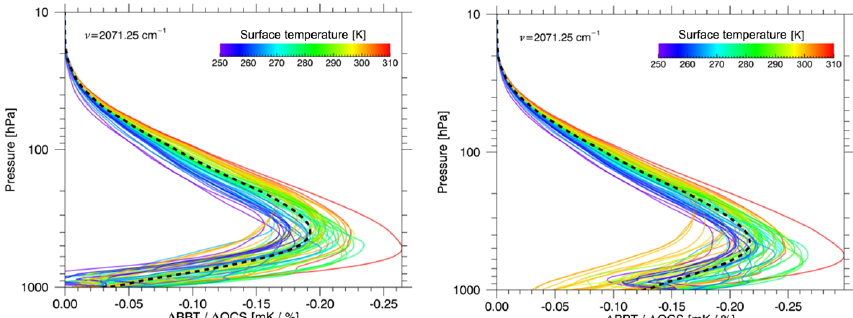
Figure 2. Weighting functions for IASI simulations of OCS are shown from vertical layers 1km thick at 2071 . 25cm − 1 for the 80-atmosphere RTTOV ensemble; they are colour coded by the individual surface air temperature. The left plot represents a ground-to-surface air thermal contrast scenario of 3K, while the right figure shows a 15K thermal contrast. The dashed line represents the mean weighting function of the ensemble.